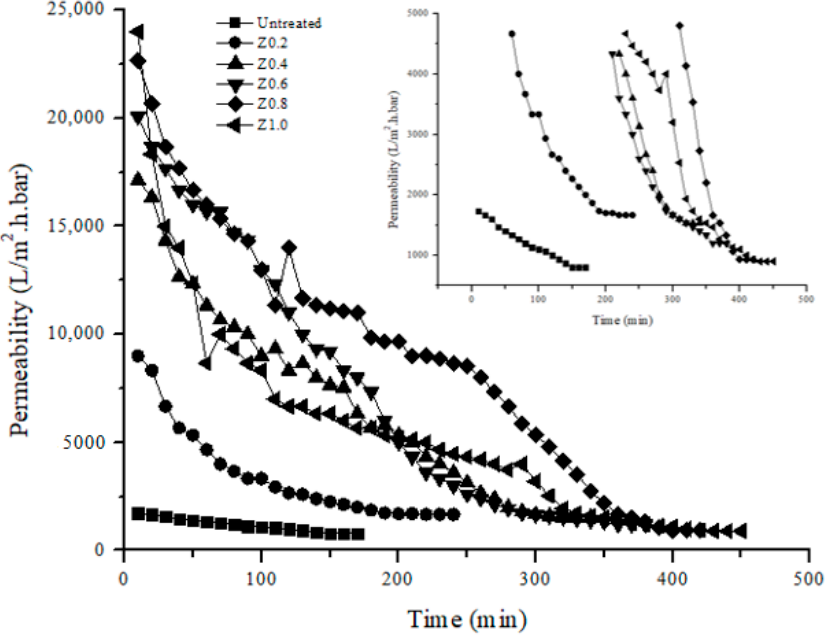
Figure 9. Produced water permeability for untreated nylon 6,6 NFM and nylon 6,6/ZIF-8 NFM with condition pressure at 0.1 bar. The inset shows PW permeability value near steady-state.